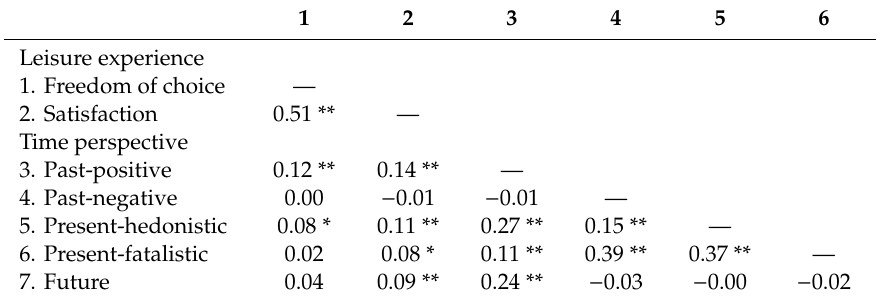
Table 3. Intercorrelations between scores obtained for experience of leisure activities and time perspective factors.